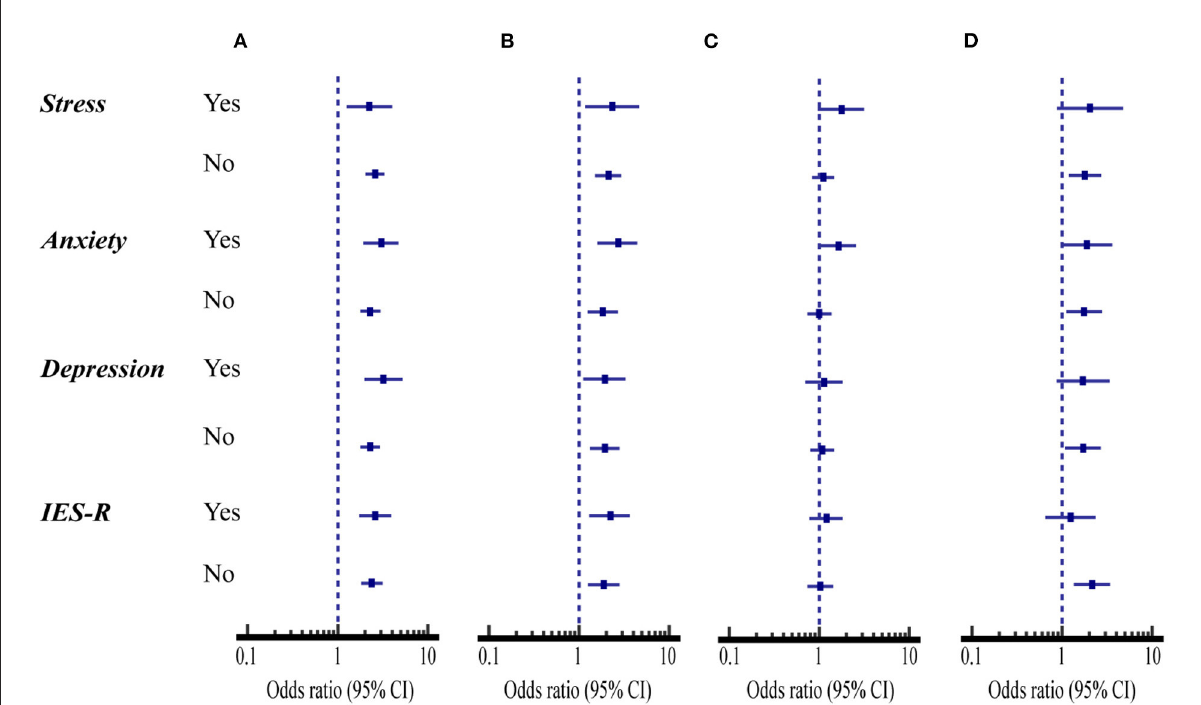
FIGURE2 Comparison of mental health status and psychological impacts with the compliance with four health measures between students with normal hearing (SNH, n = 1,104) and with hearing disability (SHD, n = 485). (A) Avoiding sharing of utensils during mealtime. (B) Washing hands with soap and water. (C) Washing hands immediately after coughing, or sneezing, rubbing the nose. (D) Wearing masks with or without the pandemic symptoms.